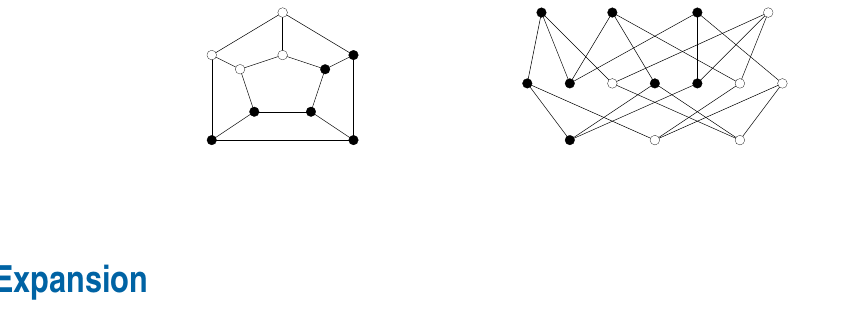
Figure 2. Graphs of order 10 and 14 with a strong security number equal to 6 and 8, respectively, black vertices form a minimum strong secure